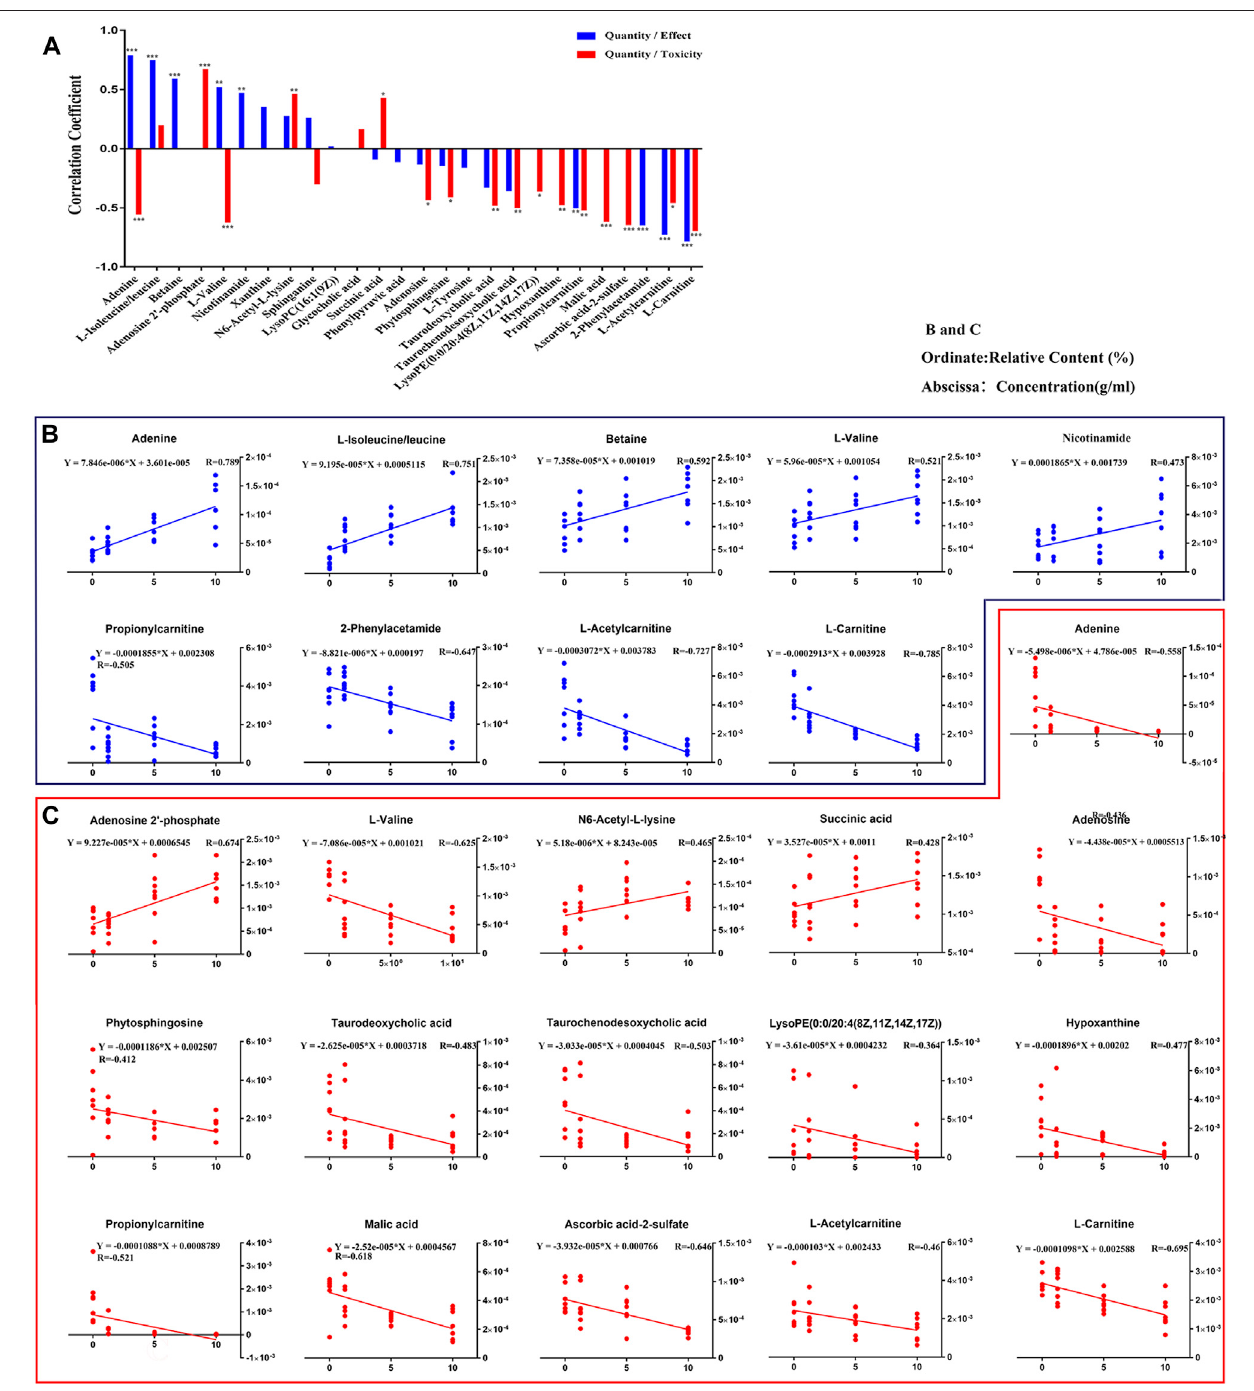
FIGURE9| RelationshipsinvolvedinDose-EffectandDose-ToxicitywereestablishedbasedonthedifferentialmetabolitesinbothCUMSandhealthyratsfollowing PBR treatment. Correlation of Quantity/Effect and Quantity/Toxicity (A) . Regression curve of Dose-Effect (B) and Dose-Toxicity (C) .